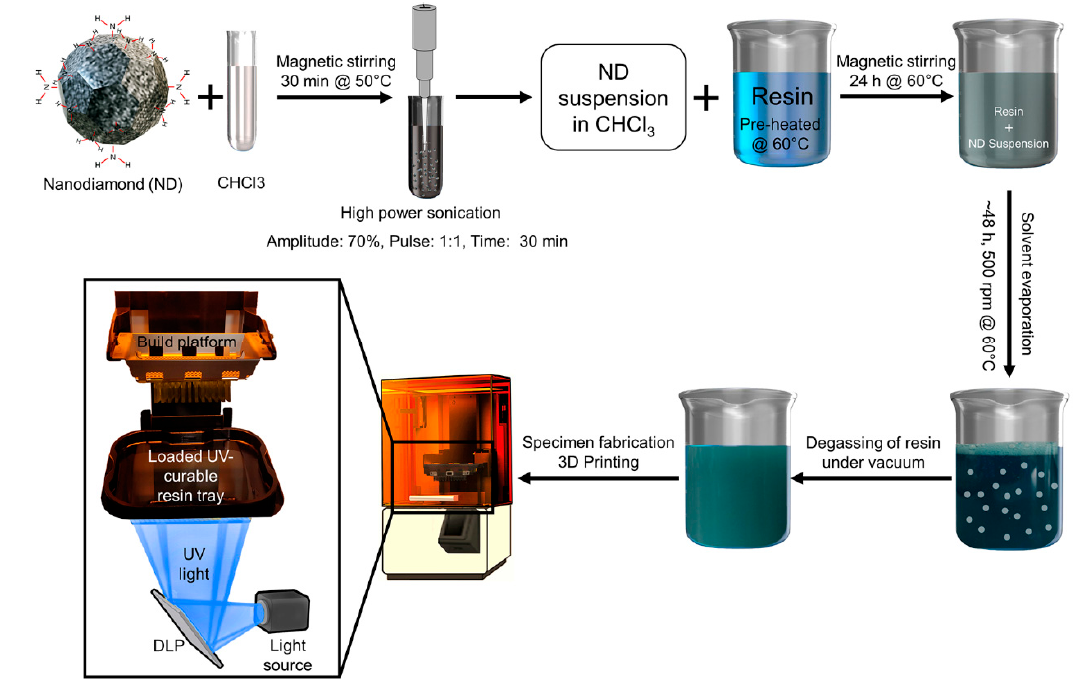
Figure 1. Depicting the process used to prepare and manufacture nanocomposites.